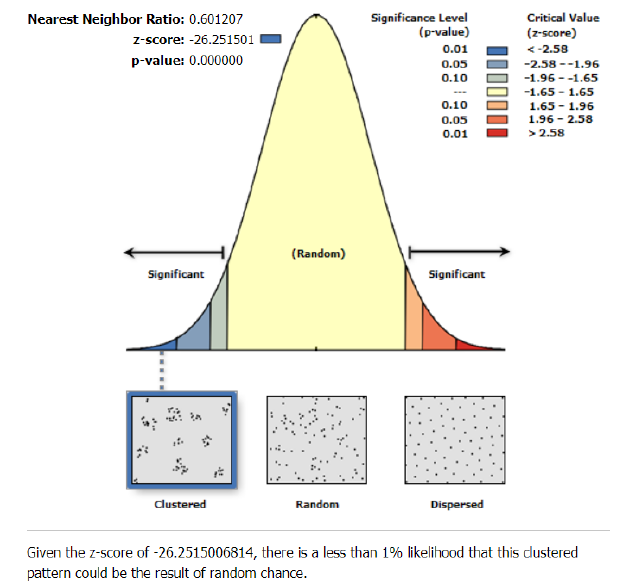
Figure 5. The ANN result for the Beitang landscape in Shangzhuang Basin. As shown in Table 1 for the area distribution of Beitang, the majority (82%) of Beitangs smaller than 1000 m 2 was homogeneously distributed; the number of Beitangs larger than 2000 m 2 was significantly reduced with 59 in total and accounted for 5%. Table 1. Statistical result for the area of the Beitang. Area of the Beitang (m 2